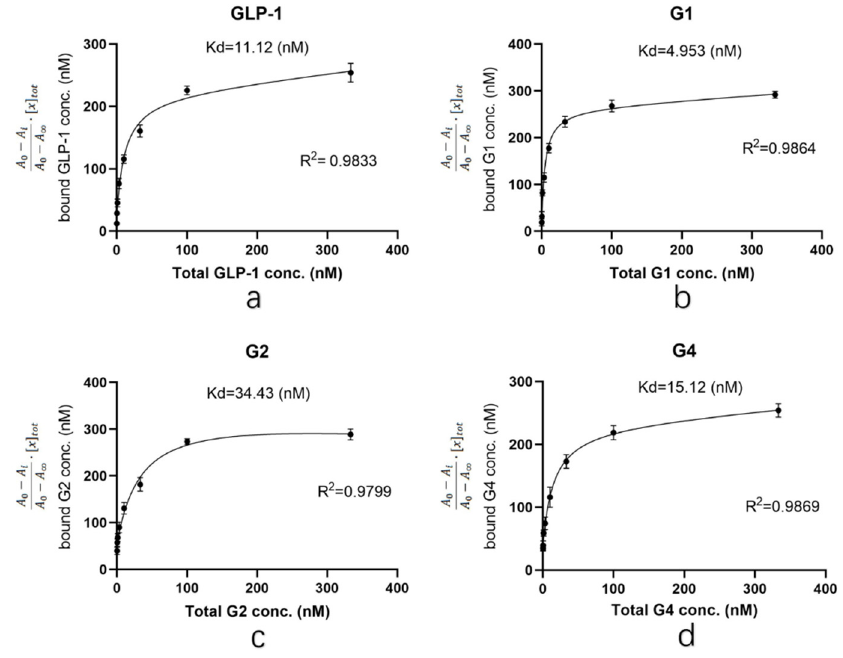
Figure 3. Affinity between GLP-1 receptor and ( a ) GLP-1; ( b ) G1; ( c ) G2; ( d ) G4.